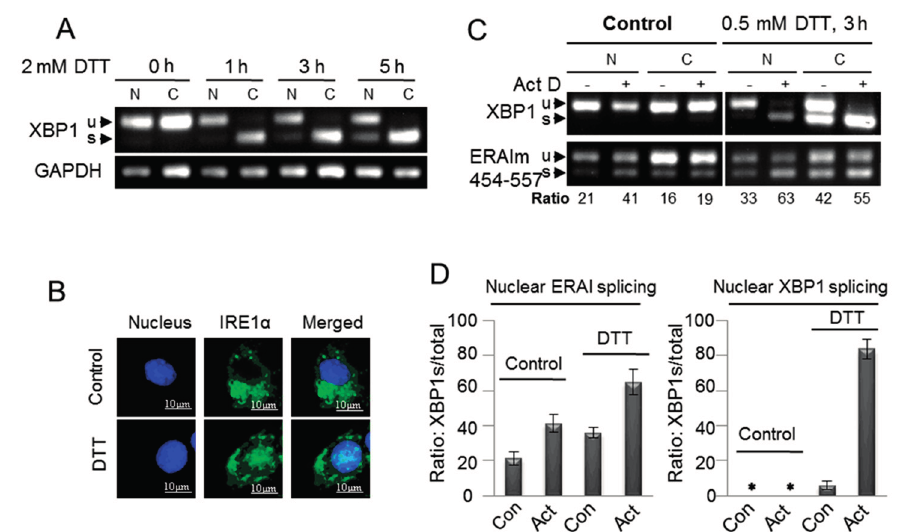
Figure 5. Promotion of the unconventional splicing of XBP1 mRNA in the nucleus by acute ER stress. ( A ) MCF-7/wt cells were fractioned after they were treated with 2 mM DTT for different time as indicated. The fractioned RNA was subjected to RT-PCR with XBP1 primers; ( B ) MCF-7/wt cells were treated with 2 mM DTT for 5 h, and then were fixed. The immunoflurorescence of the fixed cells stained with monoclonal IRE1 α antibody was imaged, as described in the Methods; ( C ) MCF-7/ERAIm454 – 557 cells were fractioned after they were treated with 0.5 mM DTT and/or 10 μ g/mLK Actinomycin D (Act D) (pretreatment for 1 h) or vehicle for 3 h. The ratio shows the percentage of spliced mRNA in total ERAIm454 – 557 mRNA including spliced and unspliced mRNA; and ( D ) Quantified fractions of nuclear spliced XBP1 or ERAI mRNA, the ratio of spliced XBP1 mRNA to total XBP1 mRNA. Data are from three independent experiments as described in ( C ). Error bars show means ± SD. * means there was no